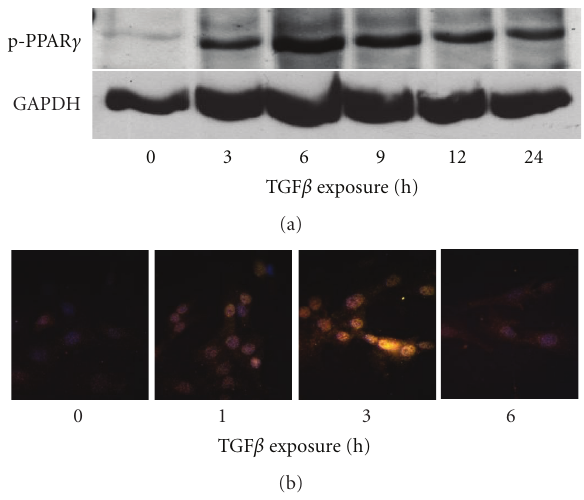
Figure 2: TGF β 1 induces the phosphorylation of PPAR γ . Primary lung fibroblasts were treated with TGF β 1 (10ng/mL) for the indi- cated times. Phosphorylation of PPAR γ was detected by Western blot (a) and immunofluorescence microscopy (b) using a phospho- specific